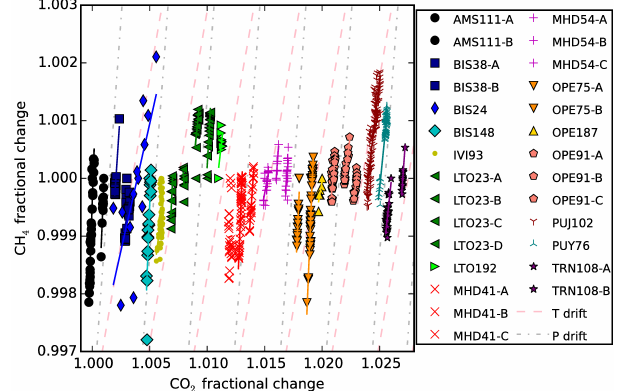
Figure 14. Data showing the fractional change in CH 4 vs. the frac- tional change in CO 2 , as derived from instrument calibrations over time. Each data set has been offset horizontally for clarity, and nor- malized to the first calibration data. The linear fit is plotted over the data. The pink dashed lines indicate the slopes correspond- ing to temperature-dependent drift, and grey dashed-dotted lines to pressure-dependent